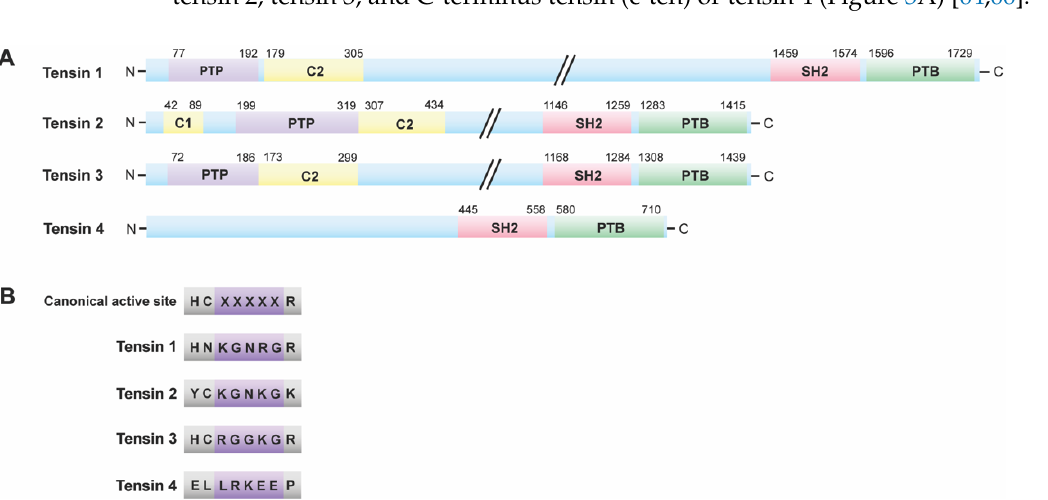
Figure 3. Tensin family: ( A ) Structure of tensin family members. All tensin family members have a C-terminal PTB (phosphotyrosine-binding) domain preceded by an SH2 (Src 2Homology 2) domain. These structures vary beyond the SH2 and PTB domains. ( B ) Active sites of tensin family members. Some tensin family members have active site motifs that differ from the catalytically active canonical PTP HCX 5 R motif. Tensin 1 and 2 are the pseudophosphatase members of the family, whereas tensin 3 possibly retains catalytic competence. Tensin 4 lacks a PTP domain; therefore, it is neither a phosphatase nor a